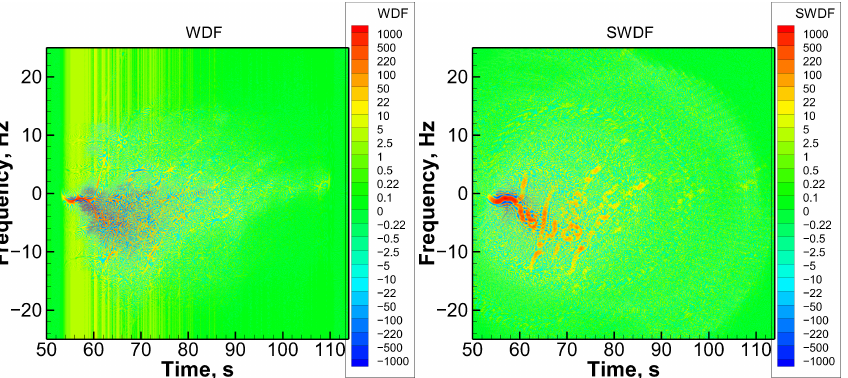
Figure 13. COSMIC-2 setting RO event observed on 15 May 2020 UTC 12:29, 0.65 ◦ N 167.78 ◦ E. Left: WDF, right: